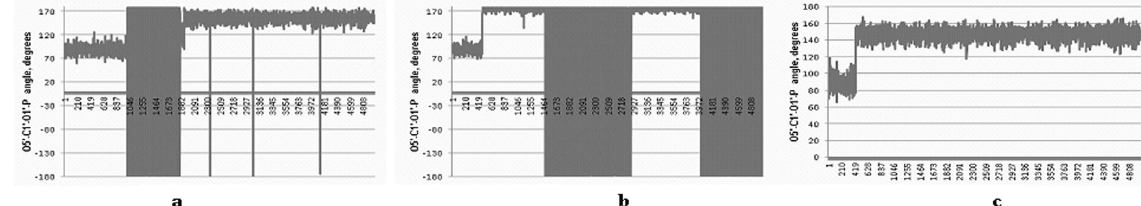
Figure 3. Sample MD trajectories for structures 1 ( a ), 2 ( b ) and 3 ( c ). Compound Atom pair